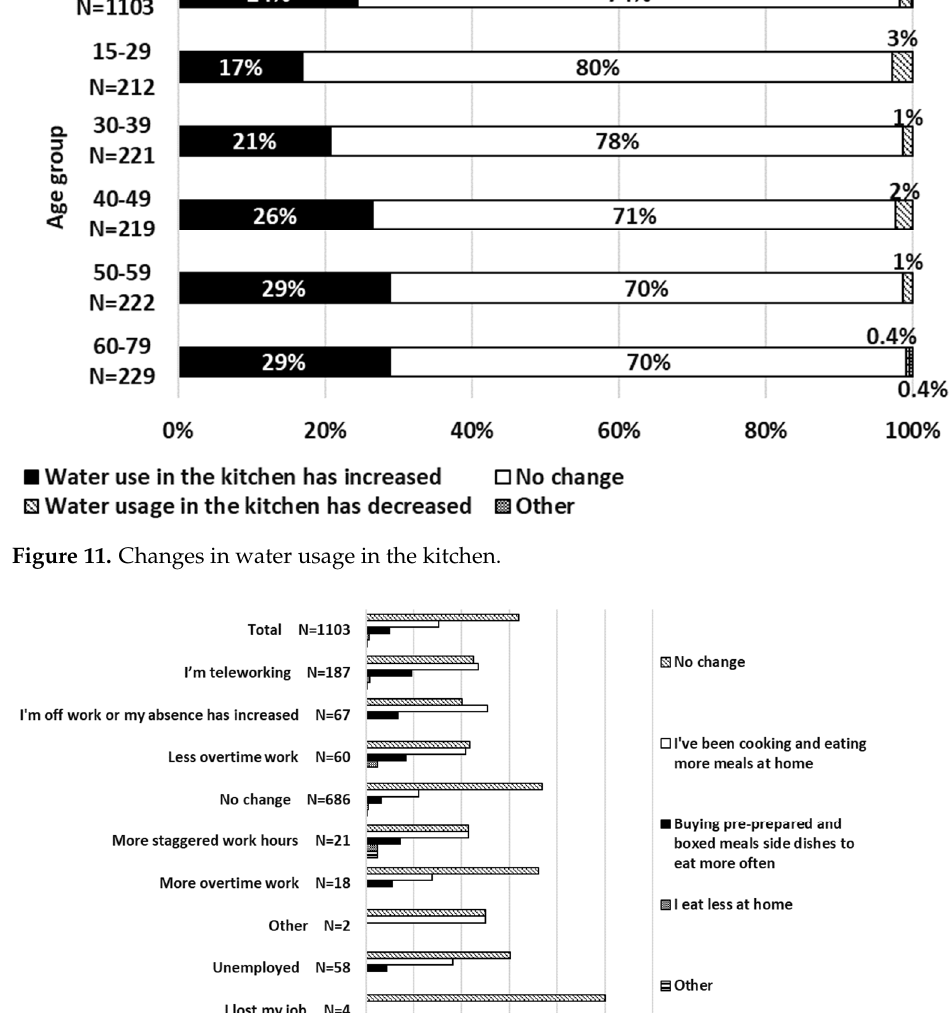
Figure 13. Changes in the frequency of cleaning for water use facilities (multiple responses). 4. Conclusions The coronavirus pandemic has not only increased people’s awareness of the need to prevent the spread of viruses but also caused lifestyle changes such as an increased amount of time spent at home. Consequently, people increased their water use activities